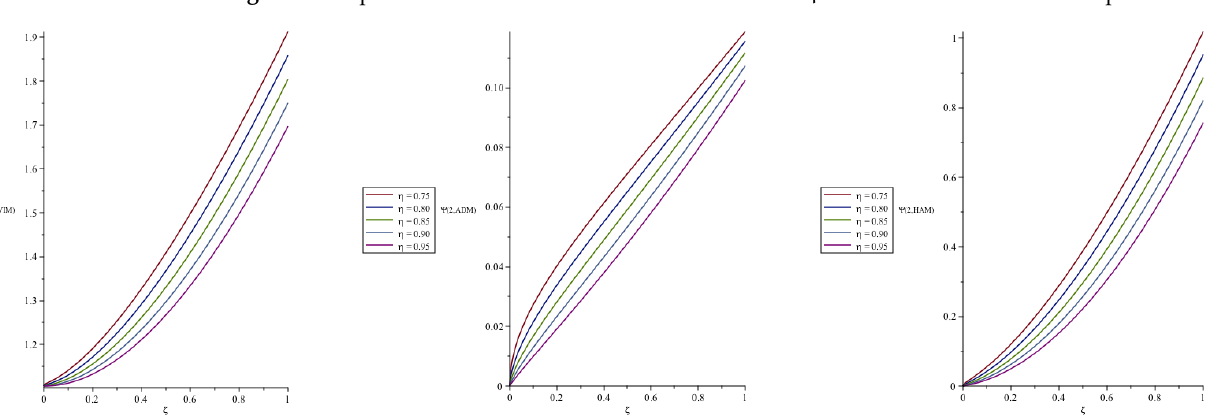
Figure 4. Graphical simulation of the absolute error when η = 0.75 and ¯ h = − 1 for Example 2.